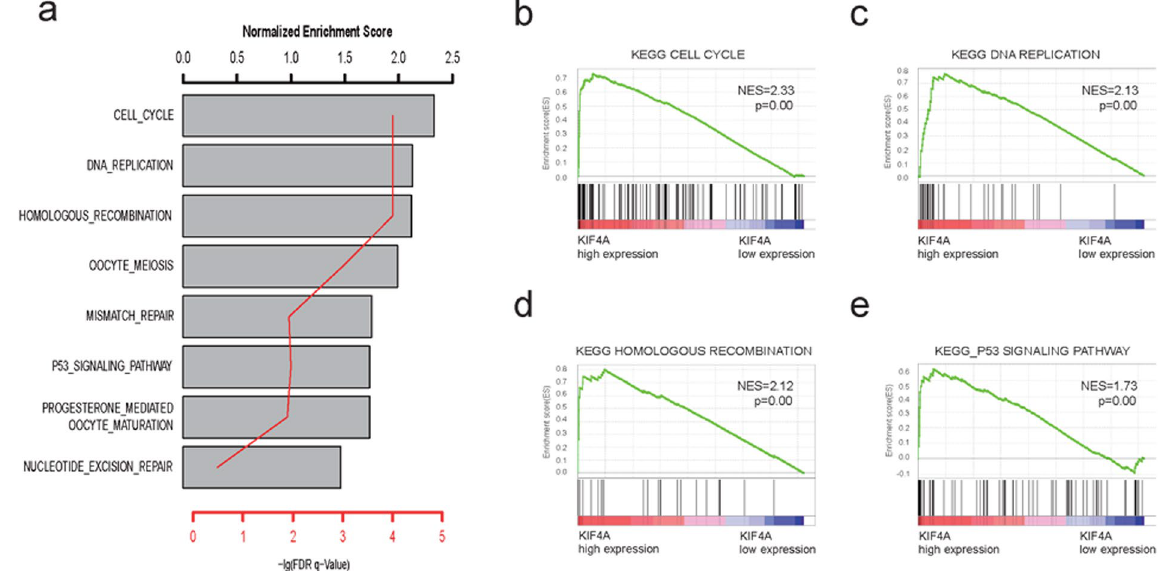
Figure 5. Gene sets enrichment analysis delineates associated with KIF4A expression level in the TCGA liver cancer cohort. Several cancer related signaling pathways were significantly enriched in the high-KIF4A group ( a ), such as cell cycle ( b ), DNA replication ( c ), homologous recombination ( d ) and p53 signaling ( e ) pathway. Normalized enrichment score (NES) is used to evaluate enrichment result. The –log p indicates the -log 10 transformed FDR p value of the corresponding